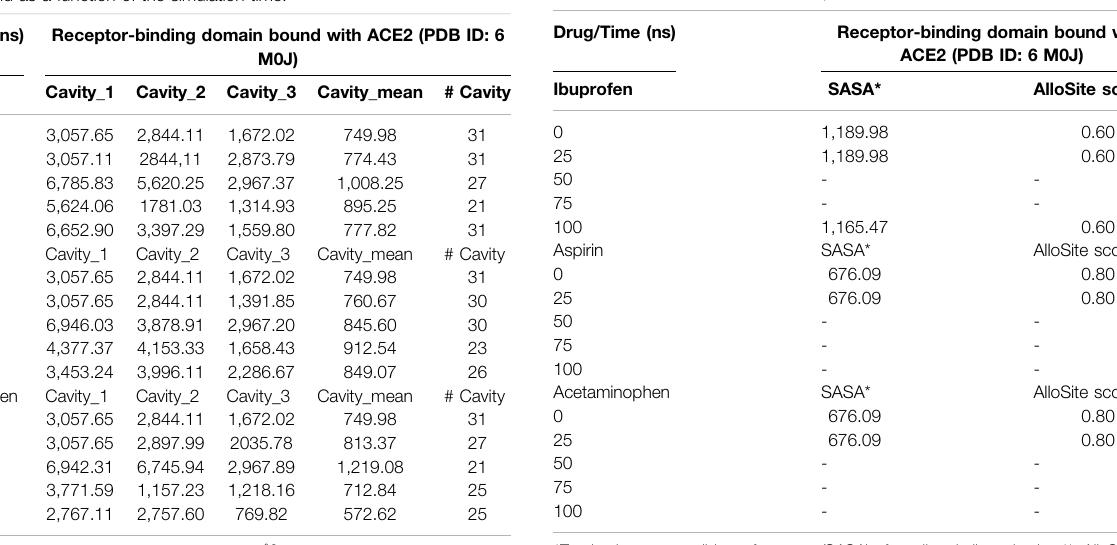
Frontiers in Physics |